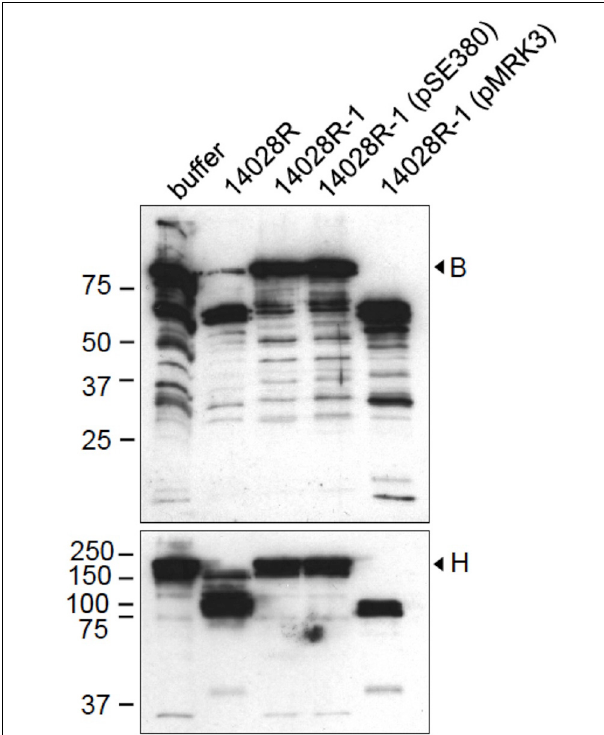
FIGURE 1 | Cleavage of factors B and H by S. enterica is PgtE-dependent. S. enterica 14028R, its (cid:2) pgtE -derivative 14028R-1 and PgtE (pMRK3)- or empty vector (pSE380) -complemented 14028R-1 strains were incubated with factors B or H (33 μ g/ml) for 4h. The reduced supernatants were immunoblotted with polyclonal antibodies against factors B or H. The assays were conducted at least twice with consistent results. FIGURE 2 | Cleavage of factor B by recombinant E. coli expressing